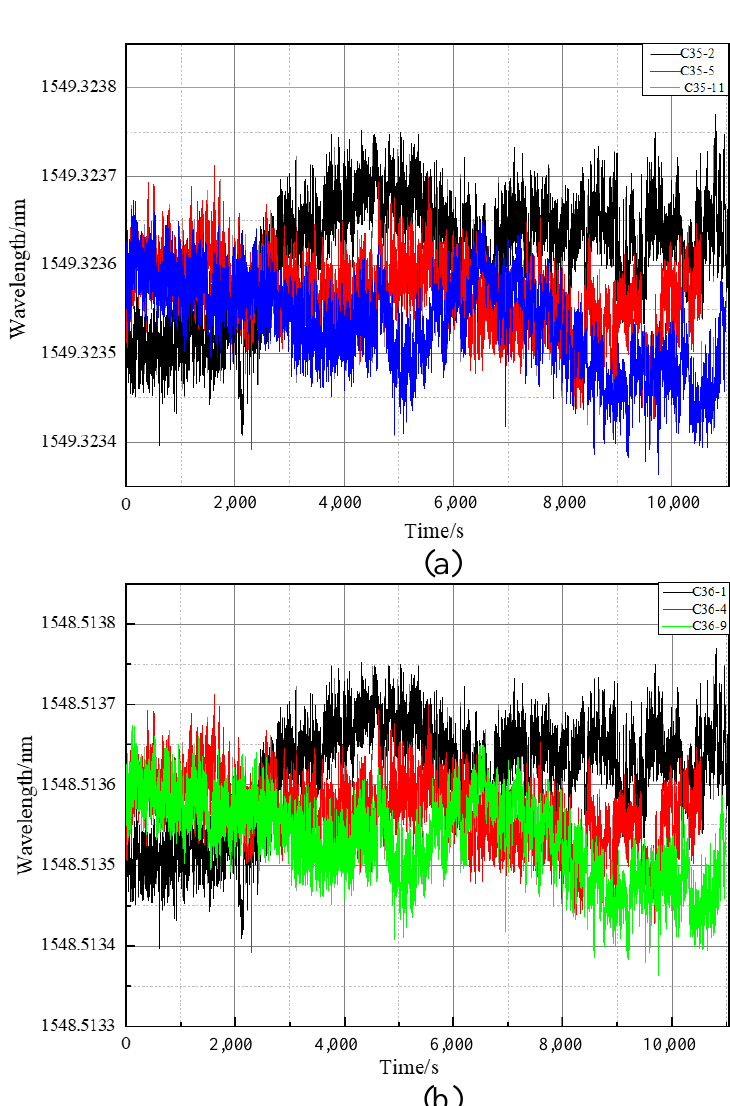
Figure 6. Measured wavelength variations of the SFP transceiver for C35 and C36